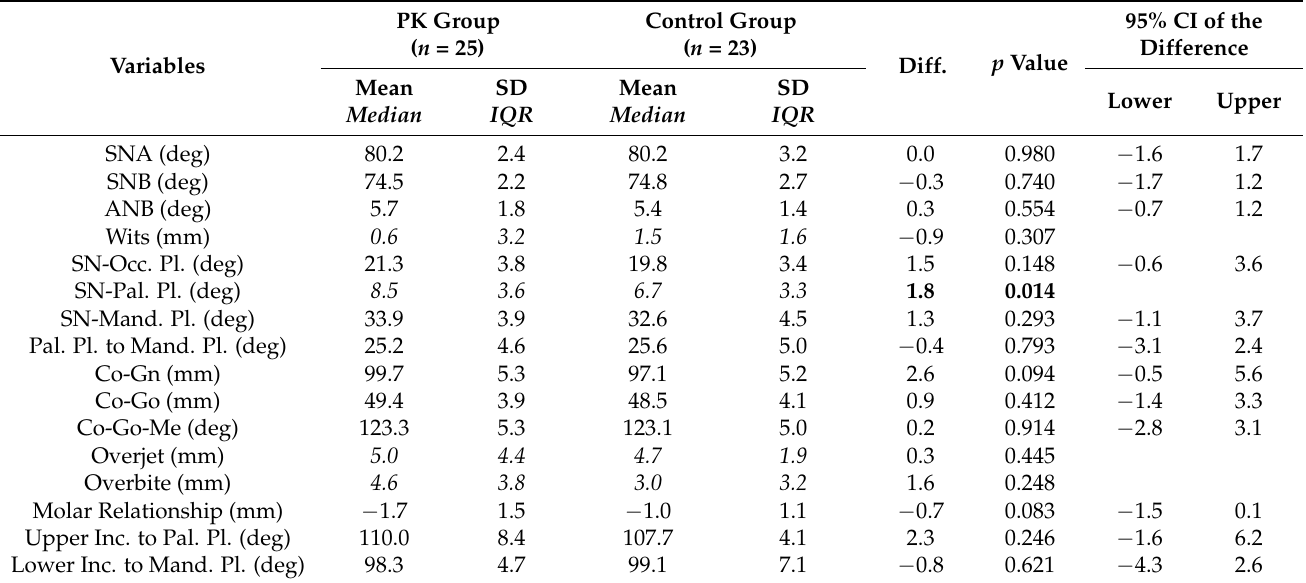
Table 2. Descriptive statistics and statistical comparisons (independent-samples t -test) for the starting forms (cephalometric values at T1).